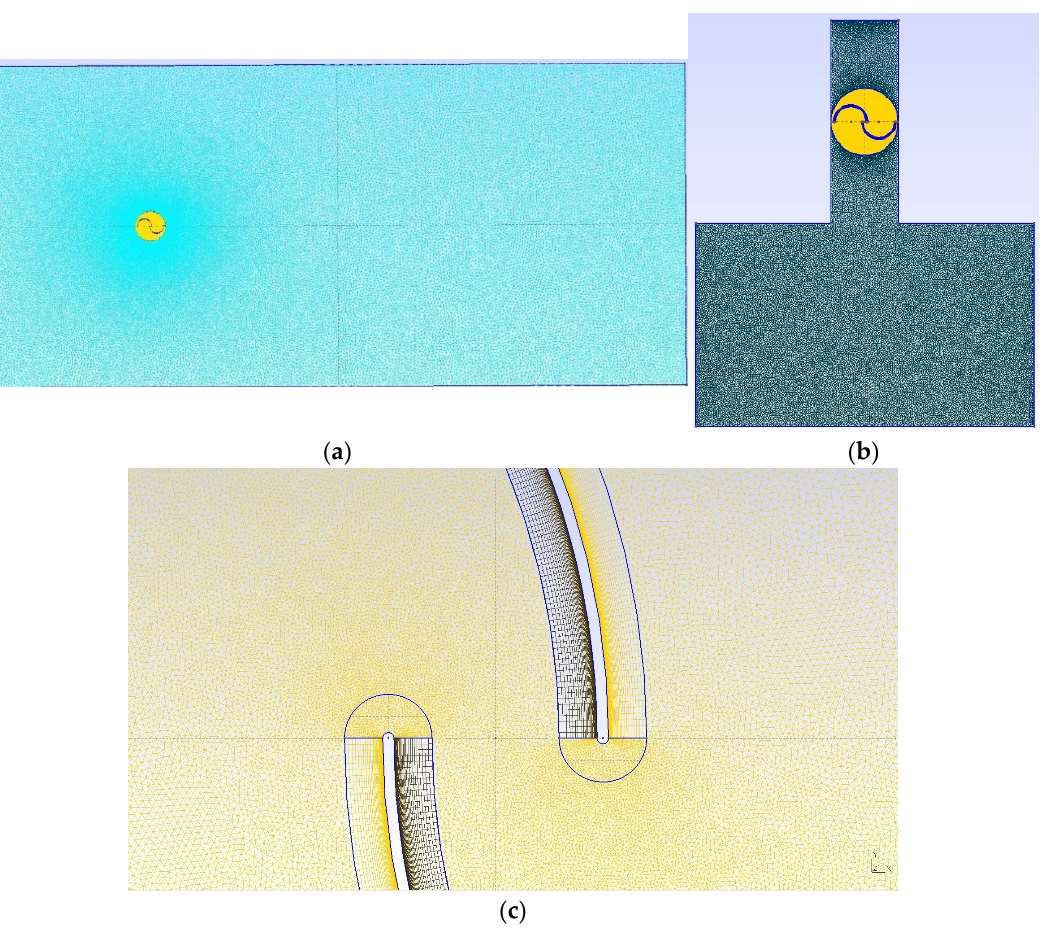
Figure 3. Employed mesh for the studied cases: ( a ) turbine in the open channel ( Case 1 ), ( b ) turbine in an OWC chamber domain ( Case 2 and Case 3 ), ( c ) detail of grid refinement the surfaces of the blades. Table 2. Grid independence test for a free turbine with Re D = 867,000, λ = 1.25, and R S =